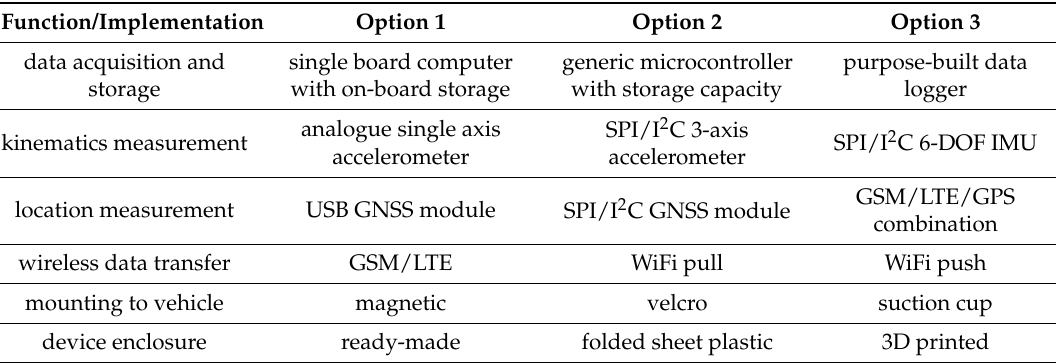
Table 1. Morphological matrix.